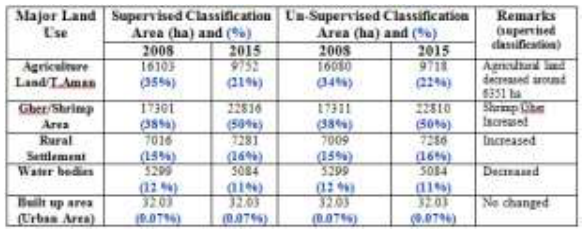
Table 3. Major land use areas during the period 2008 and 2015